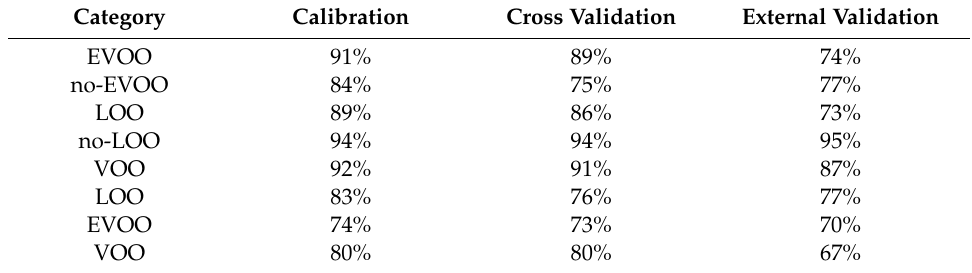
Table 2. Percentages of correctly classified samples by the 4 PLS–DA models for the quality grade classification of VOOs (EVOO vs. no-EVOO; LOO vs. no-LOO; VOO vs. LOO; EVOO vs. VOO).